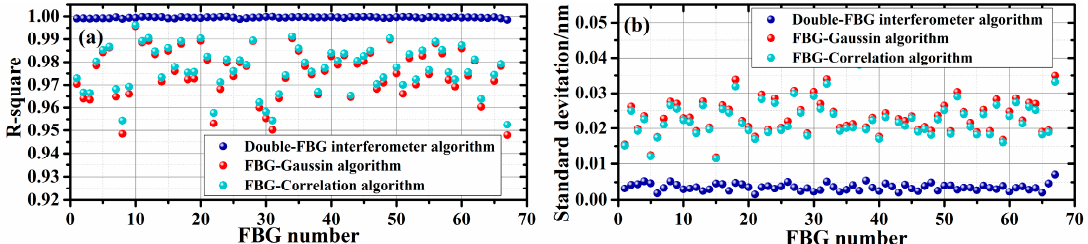
Figure 4. Comparison of the three techniques with distributed temperature sensing: ( a ) linearity of temperature sensing characterized by the R-square value; ( b ) wavelength demodulation accuracy.